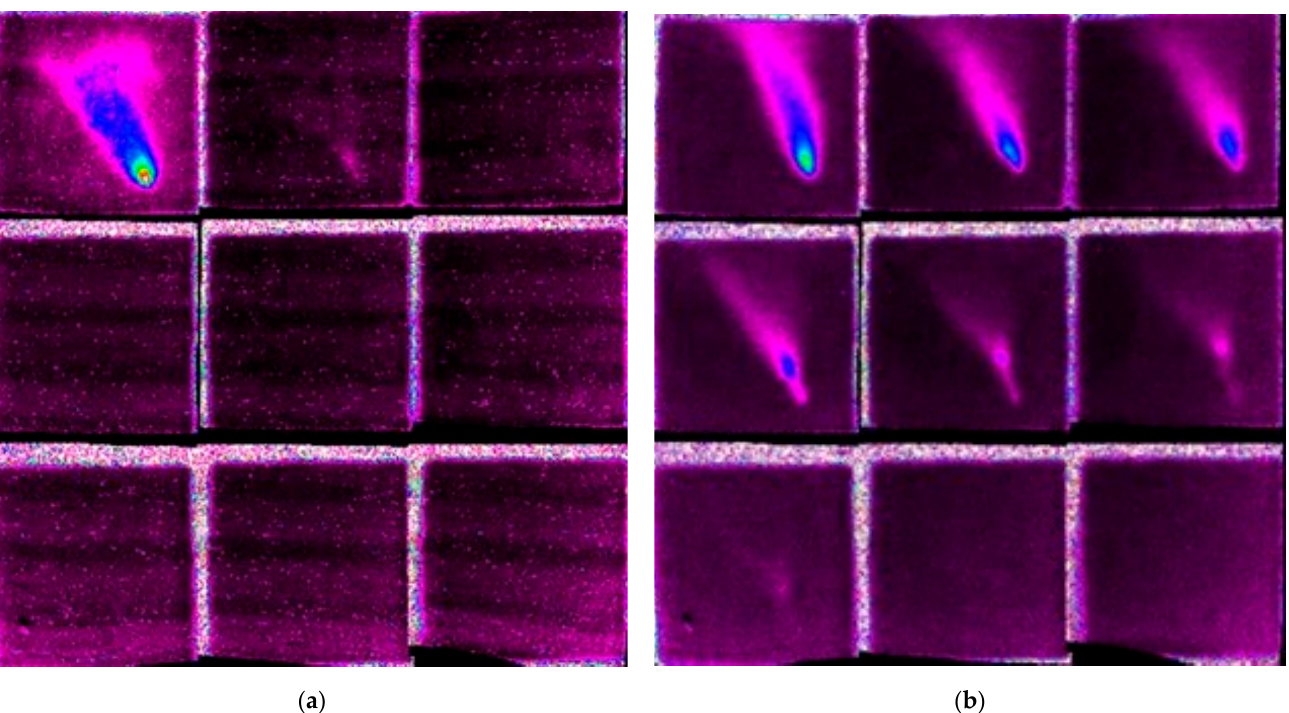
Figure 4. Streamer corona flash ( a ) without upward leader transition (frame duration 3.5 µs, pause between frames 0.1 µs, frame size 0.75 × 0.75 m) and ( b ) with upward leader transition (frame duration 2.5 µs, pause between frames 0.1 µs, frame size 0.75 × 0.75 m).